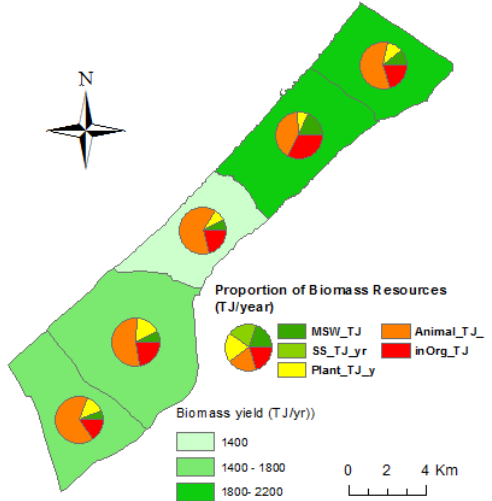
Figure 7. Integrated biomass potential (TJ/year) and the proportions of the three forms of biomass included in the study.